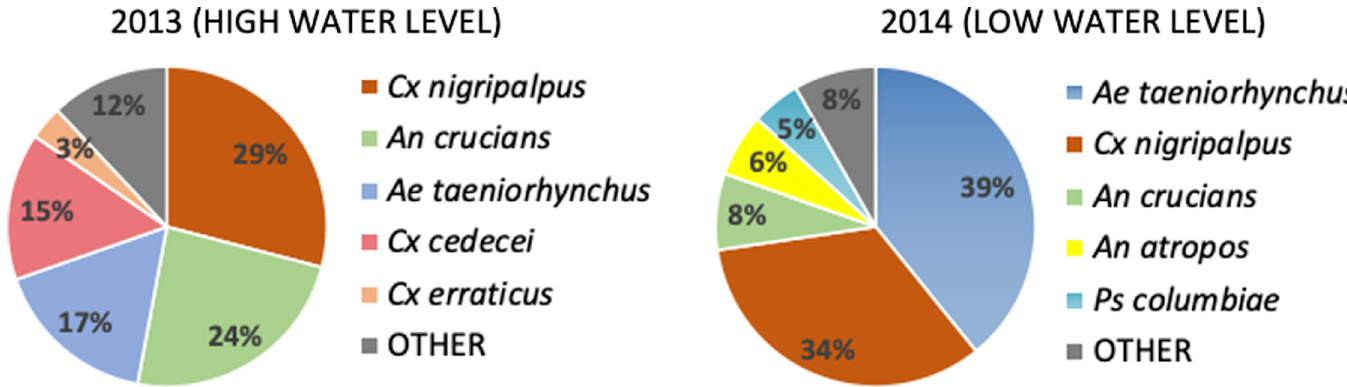
Fig 5. Mosquito species composition. Total mosquito species composition during 2013 (N = 192,440) and 2014 (N = 174,620). https://doi.org/10.1371/journal.pone.0259419.g005 Tensaw virus (TEN) and St. Louis encephalitis virus (SLEV) are more widely distributed in North America. [37–39]. In addition, 161 isolates of presumed insect-specific arboviruses were isolated from C6/36 cells. Of these, three novel insect-specific viruses (Coot Bay virus, Big Cypress virus and Long Pine Key virus) were identified and described elsewhere [29,40,41].